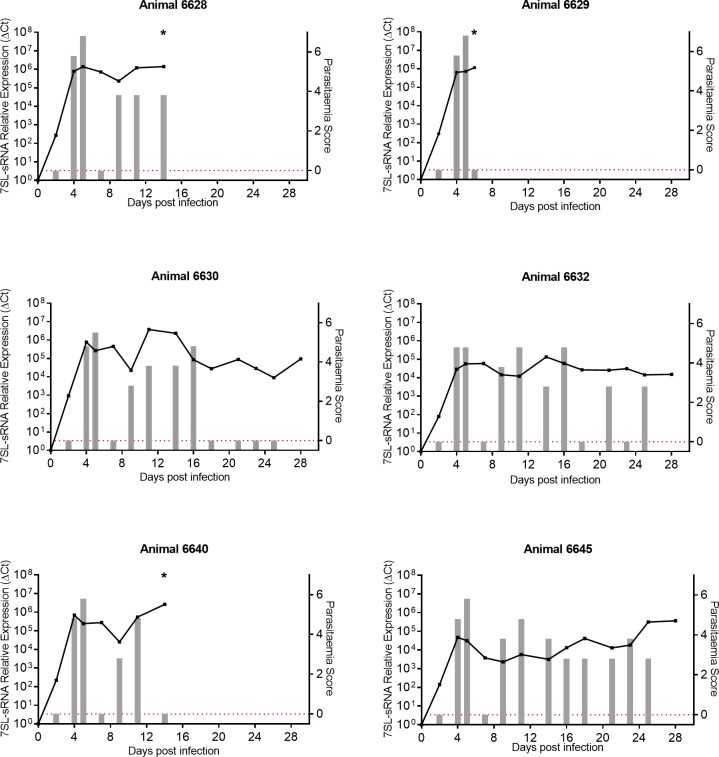
In vivo detection of T. brucei-specific 7SL-sRNA.Six calves (Holstein-Friesian male, approximately 4–6 months old) were infected with T. brucei (AnTat 1.1) and monitored for up to 28 days. Parasitaemia (right axis) was determined every 2 days on average, by microscopic detection of parasites; indicated by grey bars; approximate equivalent parasitaemia (parasites/mL): 1 = 1 x 102; 2 = 1 x 103; 3 = 1 x 104; 4 = 1–5 x 105; 5 = 5 x 105–5 x 106; 6 = >5 x 106; grey bars measuring zero (red line) indicate where parasitaemia was measured but not detected, and no bar indicates that parasitaemia was not measured. Relative expression of 7SL-sRNA as measured by RT-qPCR (left axis) is shown by the black line graph, and was calculated by normalising to an uninfected serum control. Asterisk indicates euthanasia of an animal.